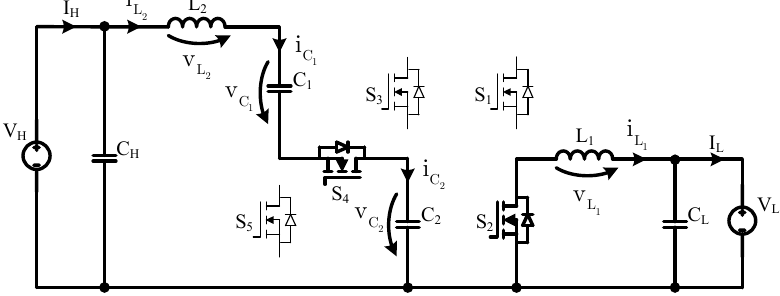
Figure 4. BHSC equivalent schematic during t off , in step-down operating mode.